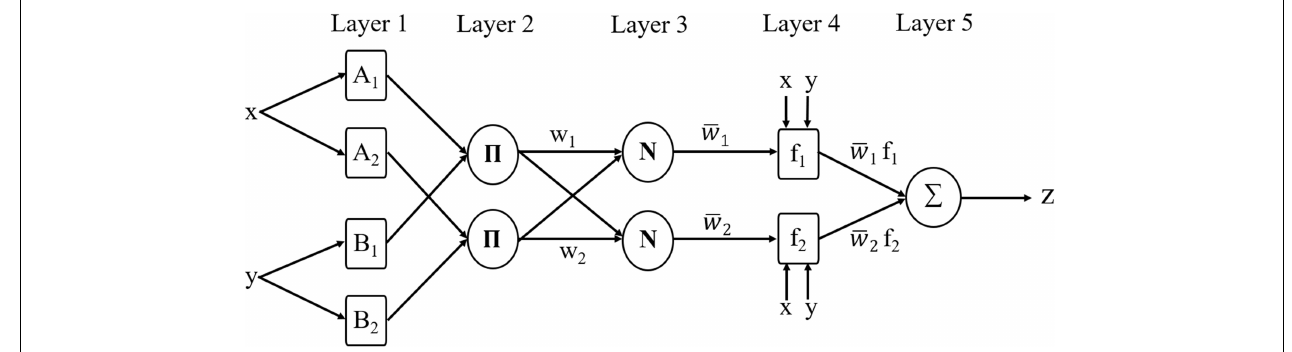
FIGURE 5 | The framework of ANFIS.